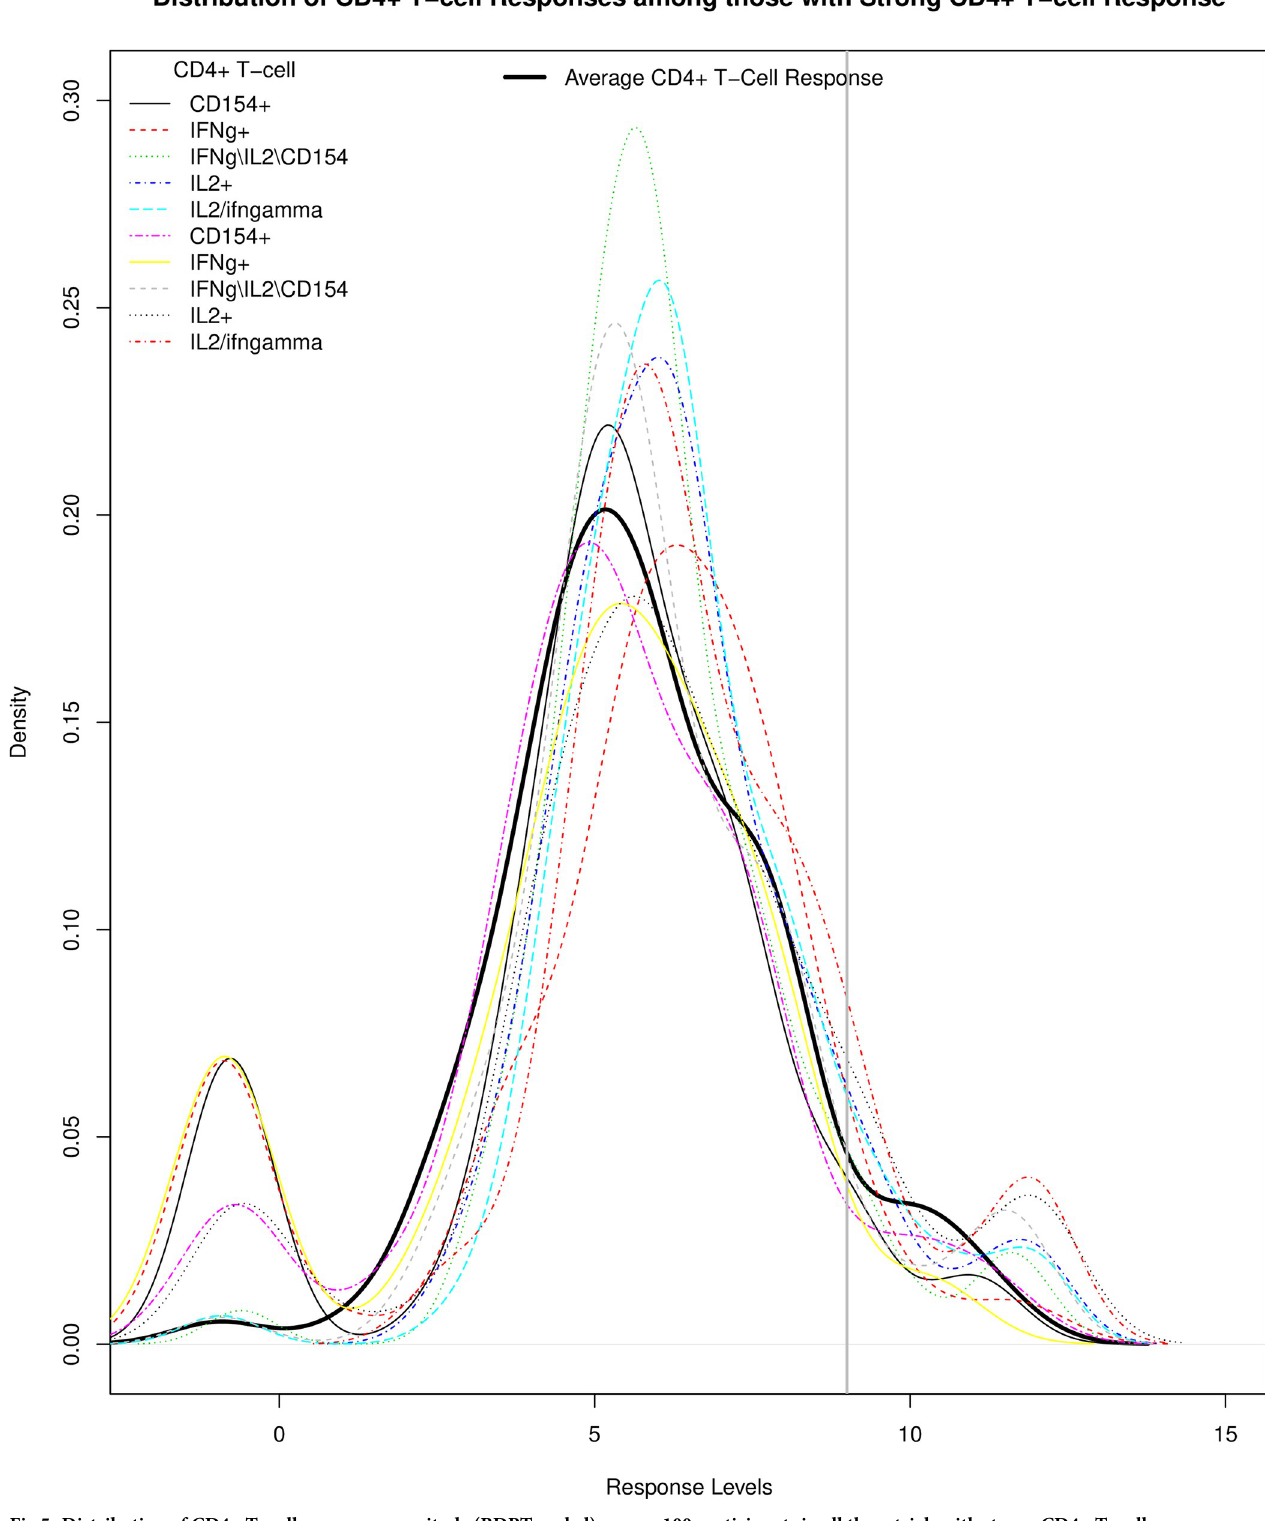
Fig 5. Distribution of CD4+ T − cell response magnitude (BDPT-scaled) among 100 participants in all three trials with strong CD4+ T − cell responses. The densities of the different CD4+ T-cell responses (color coded) and the average CD4+ T-cell response are shown by response level.